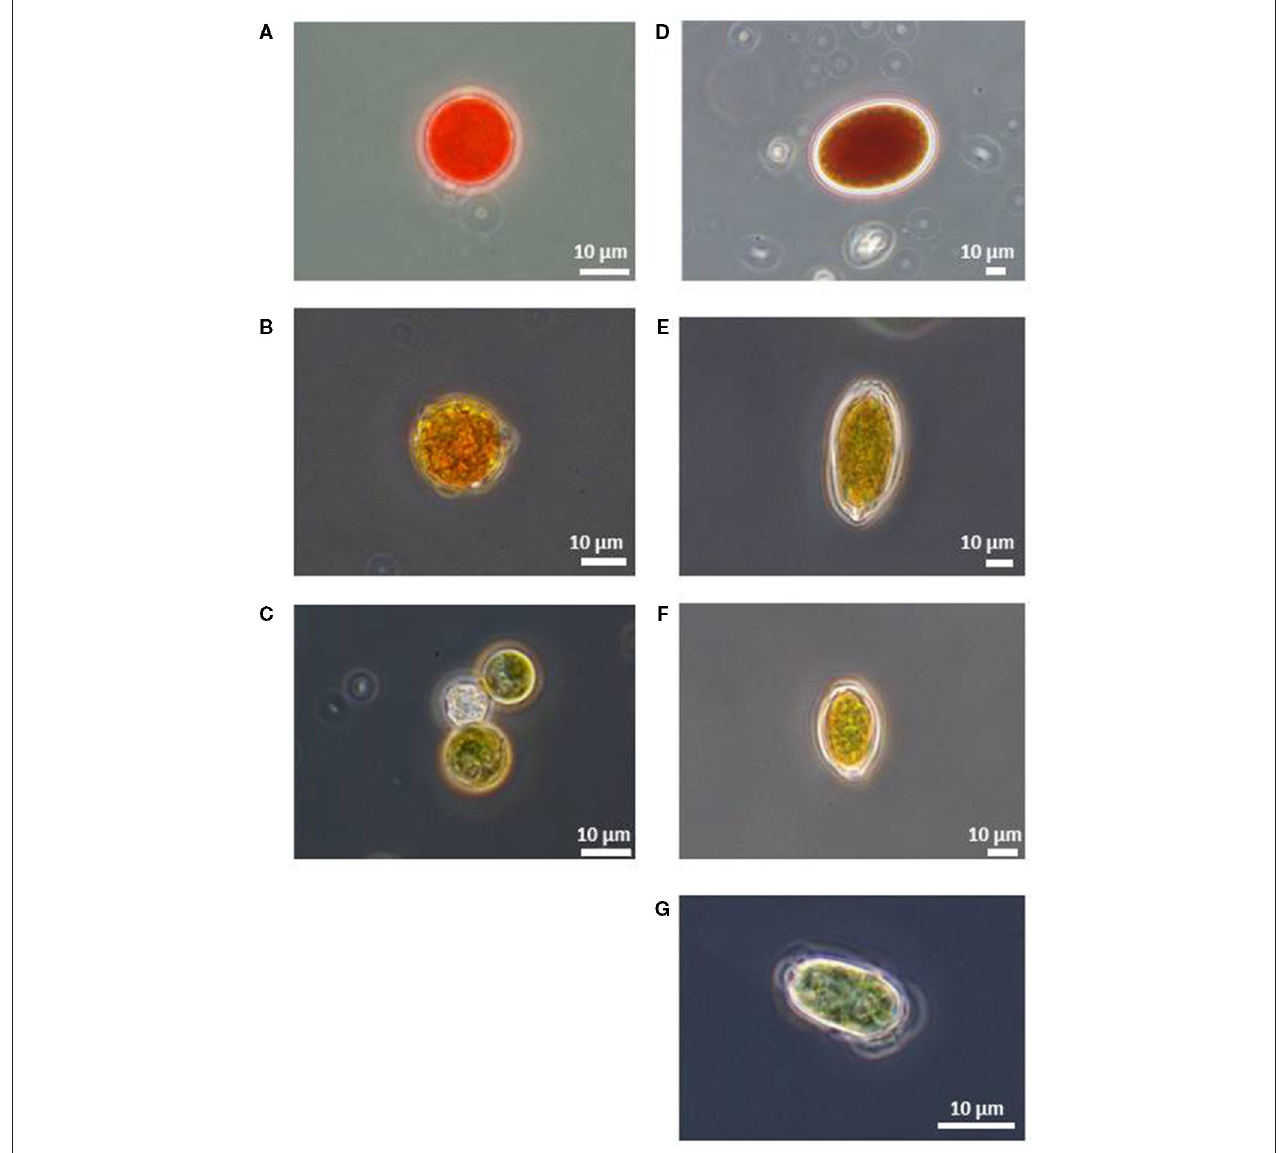
FIGURE 3 | Microscopic photographs of snow algal cells in red snow samples collected in Mt. Tateyama (reproduced from Nakashima and Takeuchi, 2017). (A) Red spherical cell, (B) Orange spherical cell, (C) Green spherical cell, (D) Red ellipsoidal cell, (E) Orange oval cell with cell wall flanges, (F) Yellow oval cell with cell wall flanges, and (G) Green oval